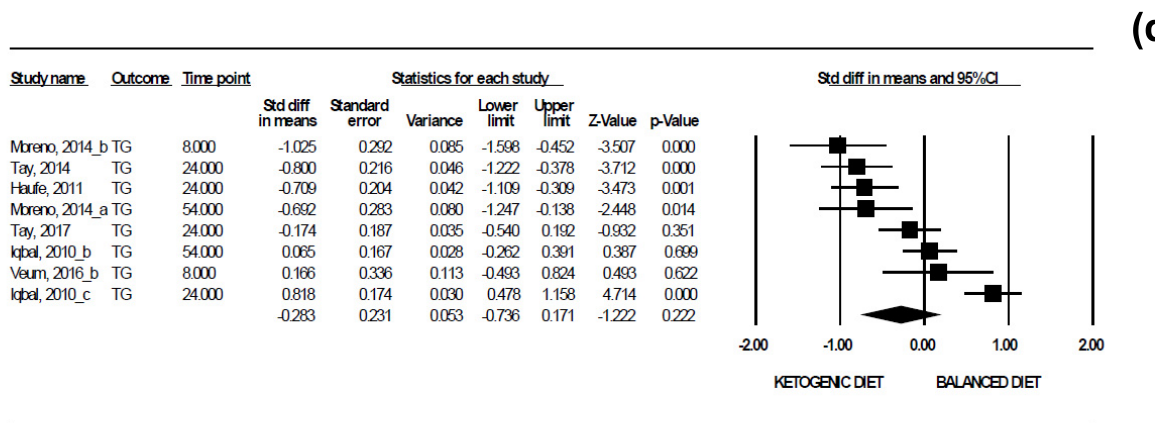
Figure 5. Forest plots showing the meta-analysis of the effects of a KD versus a balanced diet on: ( a ) Total cholesterol (COL-T), ( b ) high-density lipoprotein (HDL), ( c ) low-density lipoprotein (LDL), and ( d ) triglycerides (TG). The individual and mean effect sizes were measured in mmol/L.